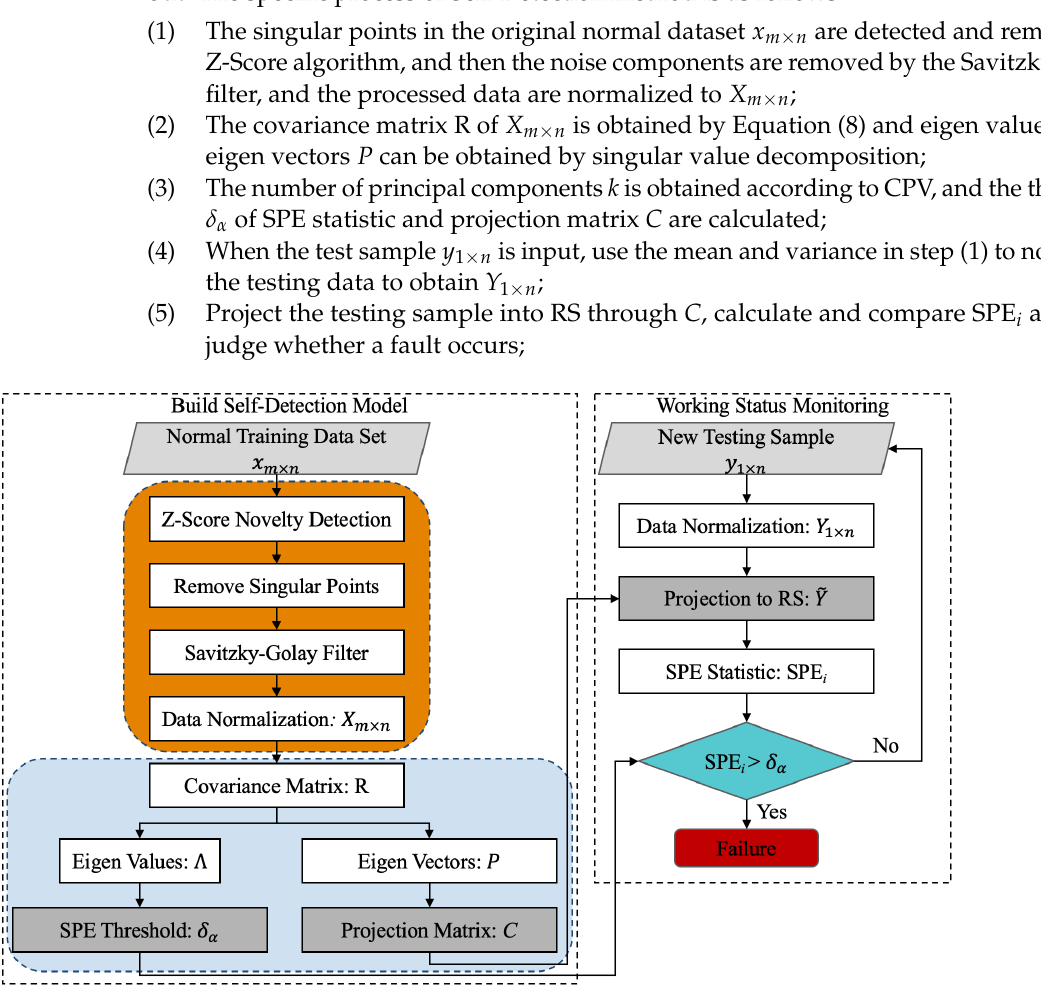
Figure 2. Flowchart of Self-Detection.